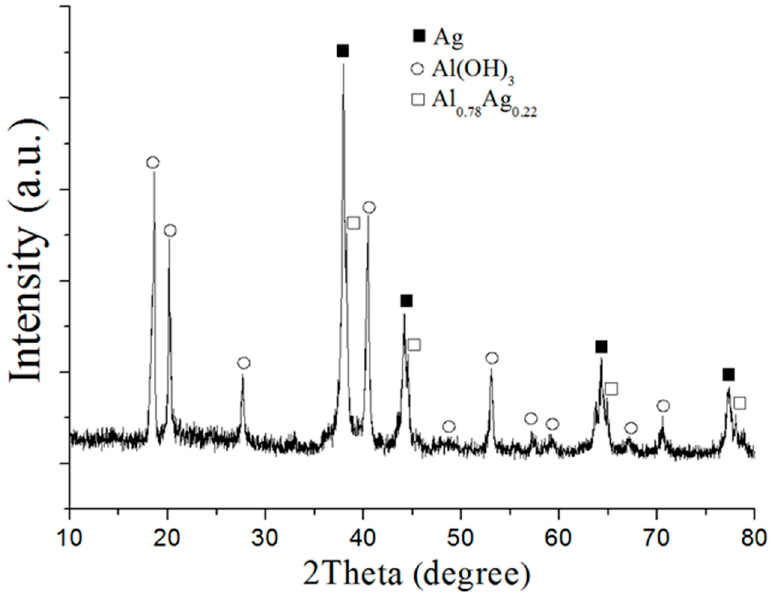
Figure 6. XRD pattern of the nanoscale structures obtained through the water oxidation of Al/Ag nanoparticles at 80% RH at 60 ° С (sample 2).